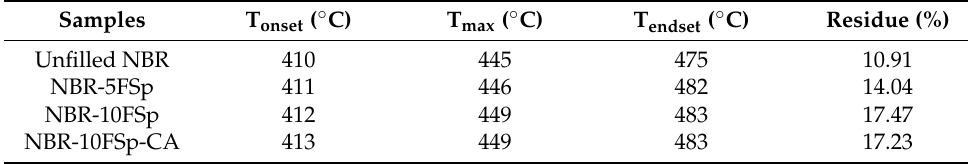
Figure 10. TGA thermograms of NBR/FSp and NBR/FSp/CA composites. Table 5. Thermal properties of NBR/FSp and NBR/FSp/CA composites.